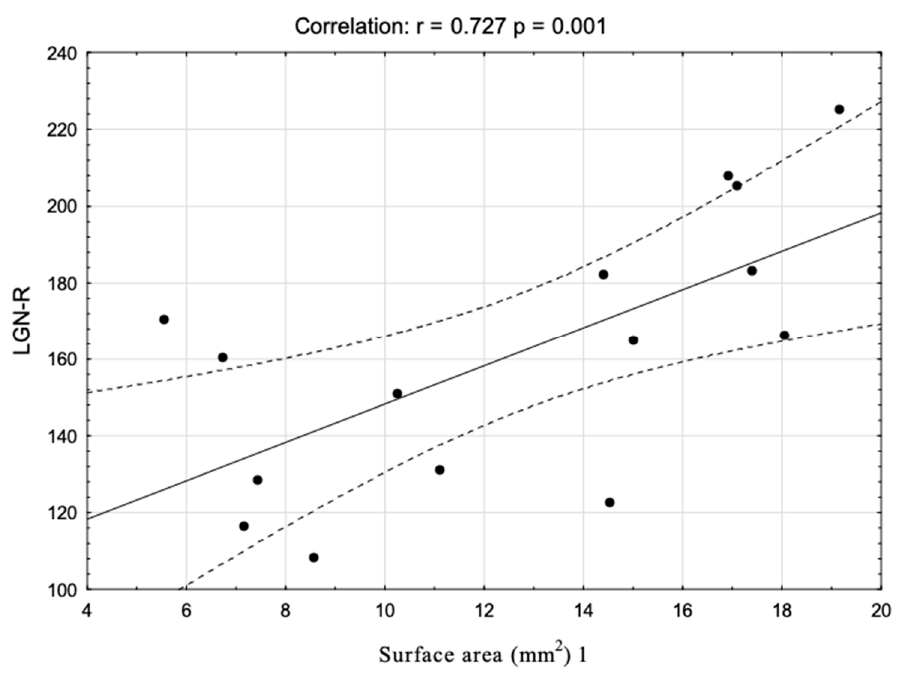
Figure 7. A correlation scatterplot showing associations between the volume of the right LGN and right optic nerve surface area 1 in the LHON group.